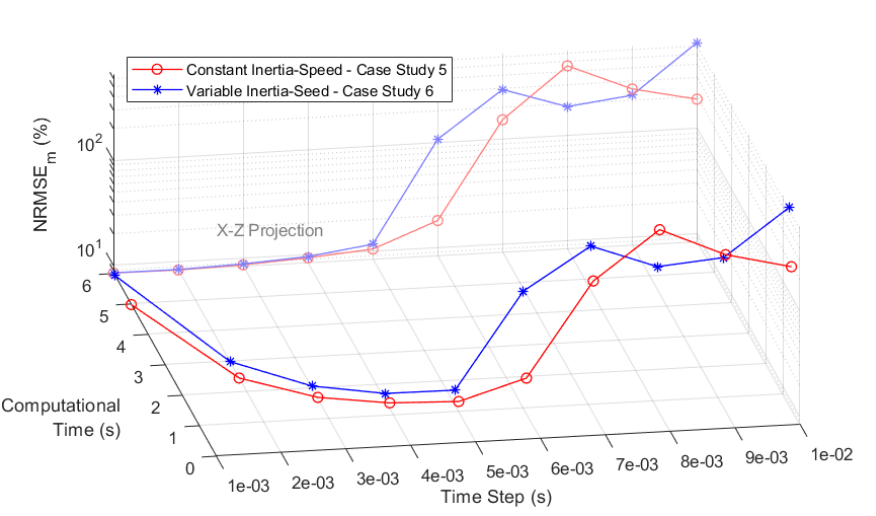
Figure 7. LTI numerical scheme time step investigation. Table 4. Convergence criterion and time step study